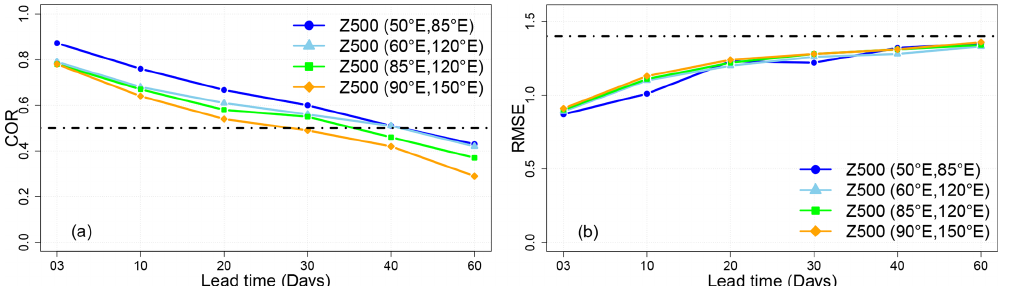
Figure B2. Comparison between the COR (a) and RMSE (b) of the SWG forecast based on analogs of Z500 computed over different geographical regions, for lead times going from 3 to 60d over the period from 1979 to 2020. The forecast was made with analogs computed over the Indian Ocean with coordinates 15 ◦ S–15 ◦ N, 50–85 ◦ E, and 15 ◦ S–15 ◦ N, 60–120 ◦ E; the Indian and Pacific oceans with coordinates 15 ◦ S–15 ◦ N, 85–120 ◦ E; and the Indian Ocean–Maritime Continent region with coordinates 15 ◦ S–15 ◦ N, 90–150 ◦ E. As the latitude is the same for the different considered geographical regions, we just mention the longitude of each domain in the